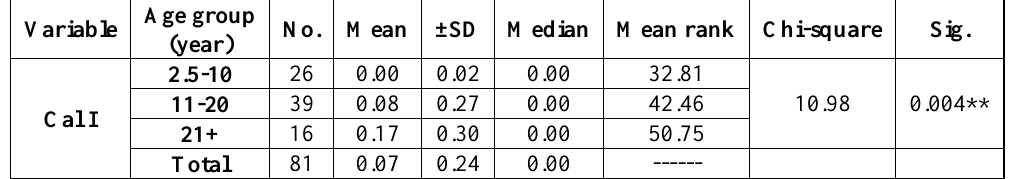
Table 5: Caries experience of primary dentition (mean and standard deviation) among patient with Juvenile Idiopathic Arthritis according to duration of illness Caries Duration of illness No. Mean ±SD experience (Year)